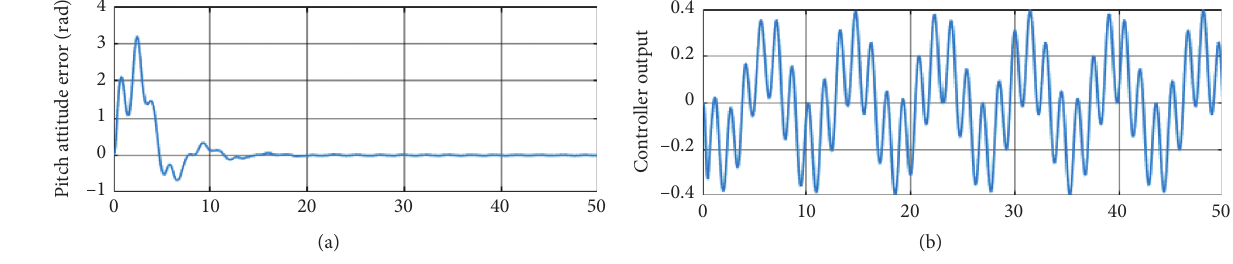
Figure 10: Time response of the system with the H